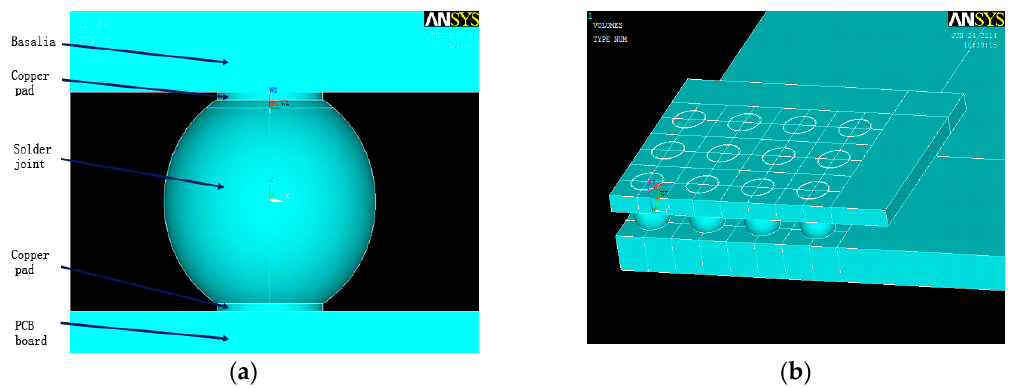
Figure 5. Simulation model of MROM TF-BGA48: ( a ) Single solder joint simulation model; ( b ) Chip level simulation model.